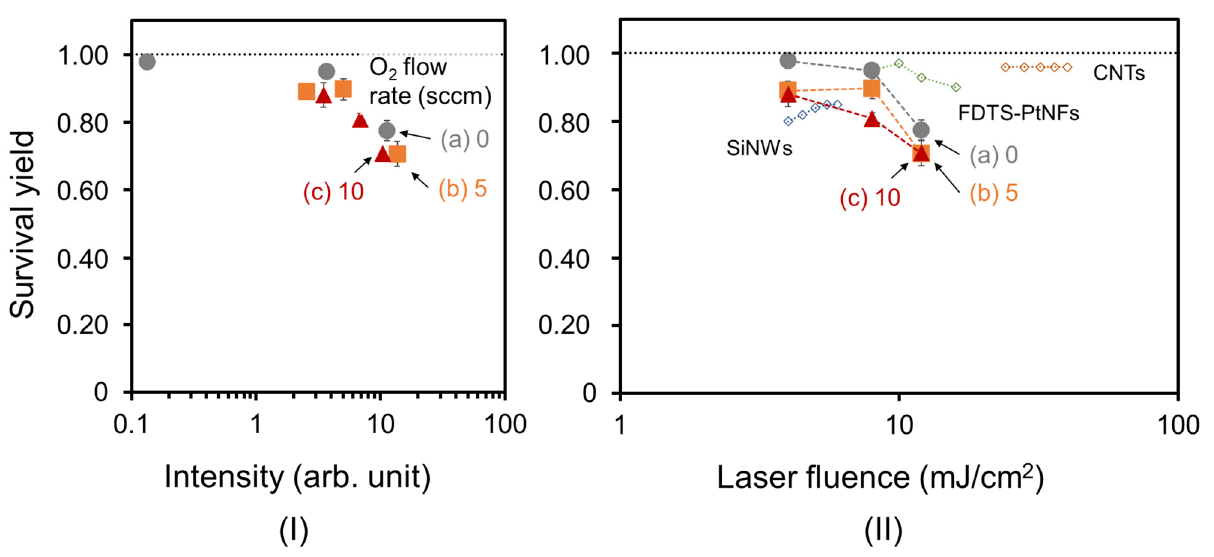
Figure 11. SY values for N-BP-Cl on high-quality CNWs ionization-assisting substrates as a function of (I) the ion intensity and (II) laser fluence : ( a ) normal CNWs, ( b ) 5-sccm-O 2 –, and ( c ) 10-sccm-O 2 – high-quality CNWs. For each CNW sample, the increase in the ion intensity corresponds to laser fluences of 4, 8, and 12 mJ/cm 2 , in that order. SY values of ( a ) normal CNWs [10], SiNWs [4], FDTS-PtNFs with a citrate buffer [14], and CNTs [13] are cited for comparison, respectively.